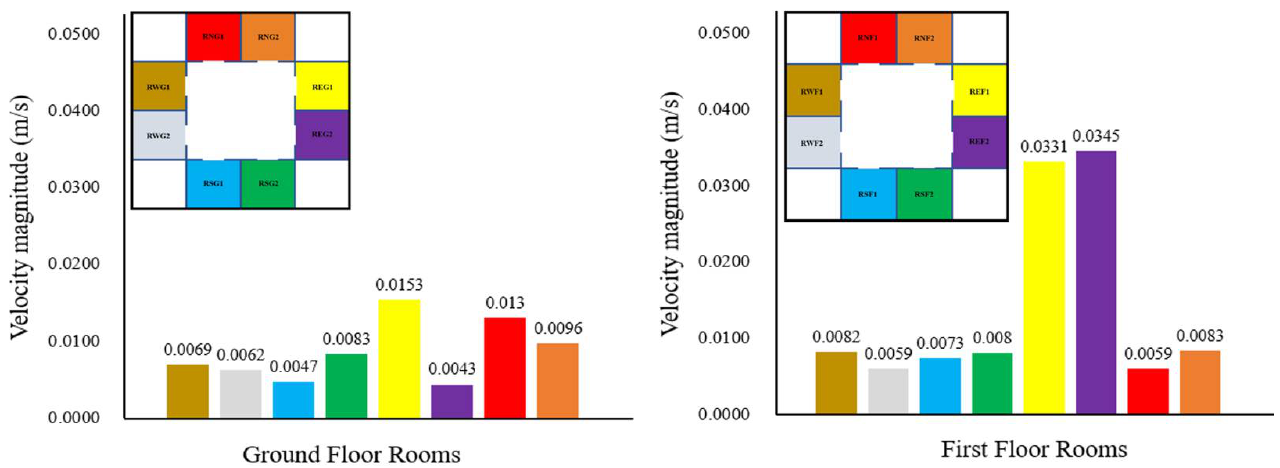
Figure 20. Average wind speed magnitude (m/s) in each room for the baseline courtyard model with four small